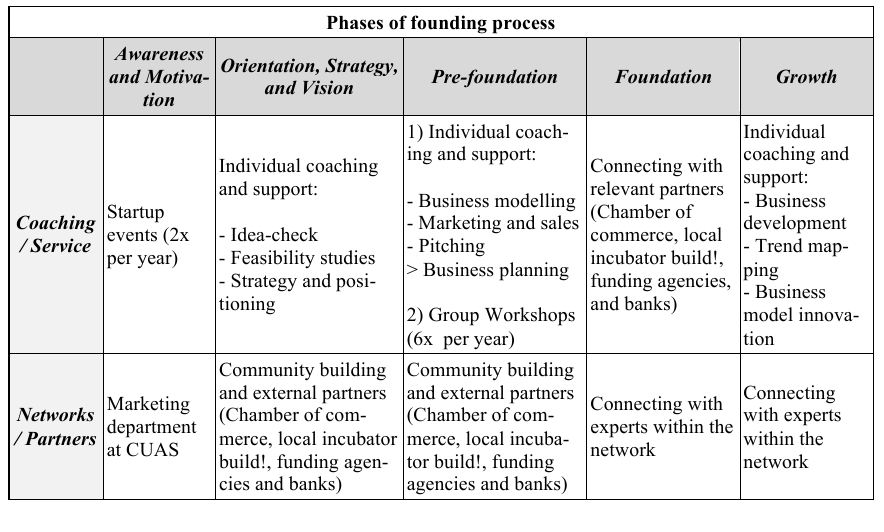
Table 1. Start-Up Initiative’s